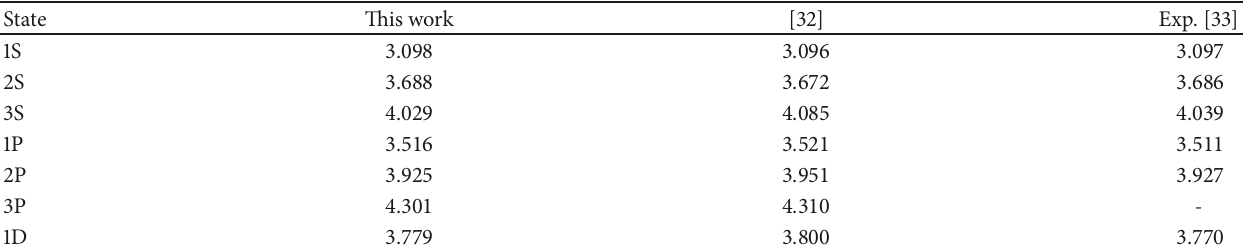
Table 8: Charmonium spectra. All results are in GeV.